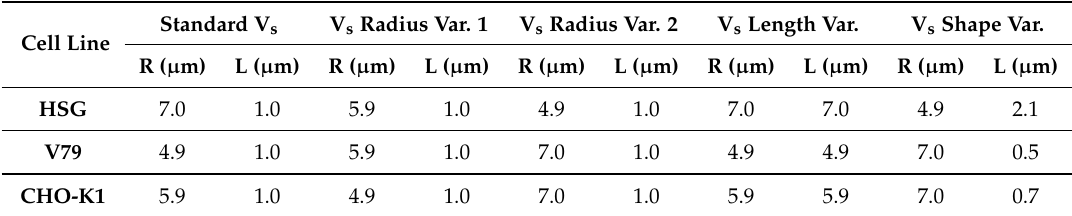
Table 2. Input variations of sensitive volume radius and thickness for the three cell lines.